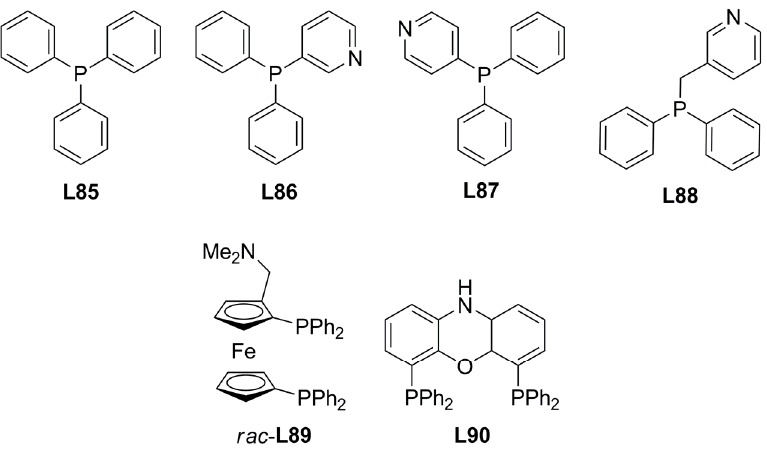
Figure 30. Phosphines for supramolecular